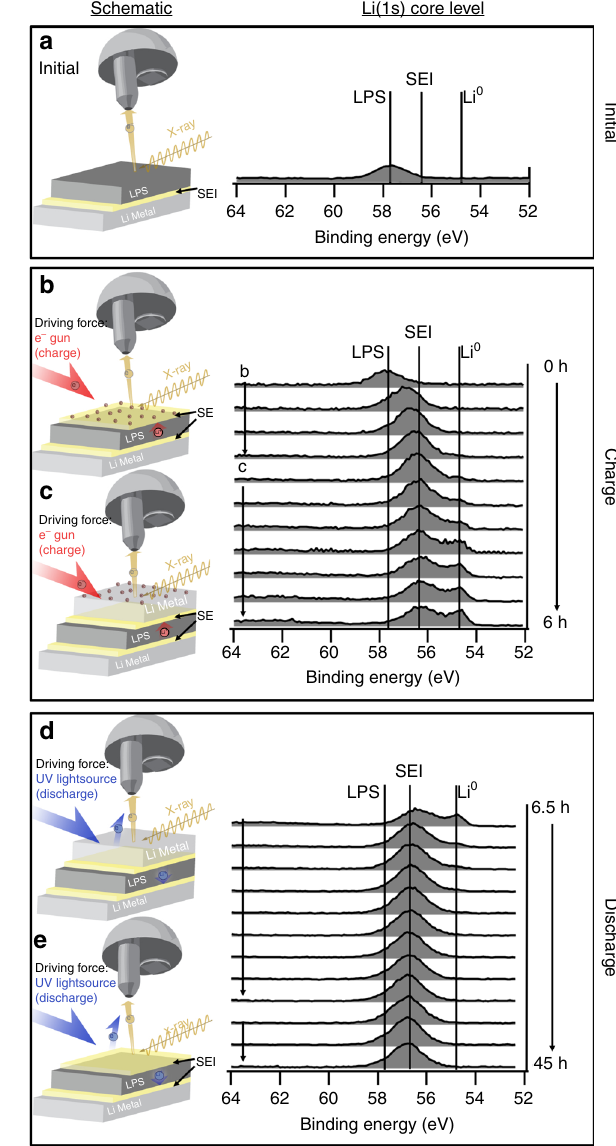
Fig. 2 opXPS schematic and Li 1s core level evolution. a Clean LPS surface, b , c SEI formation during charging, and d , e SEI evolution during